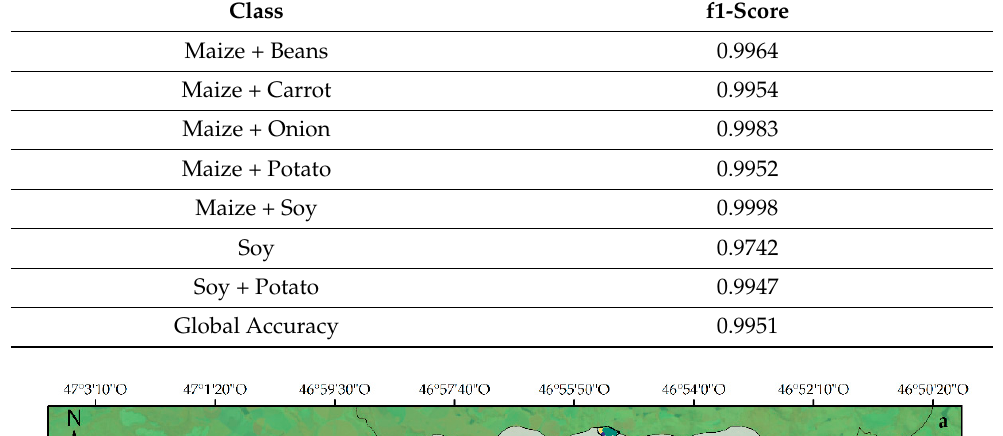
Table 3. Global accuracy and f1-scores obtained in each class.